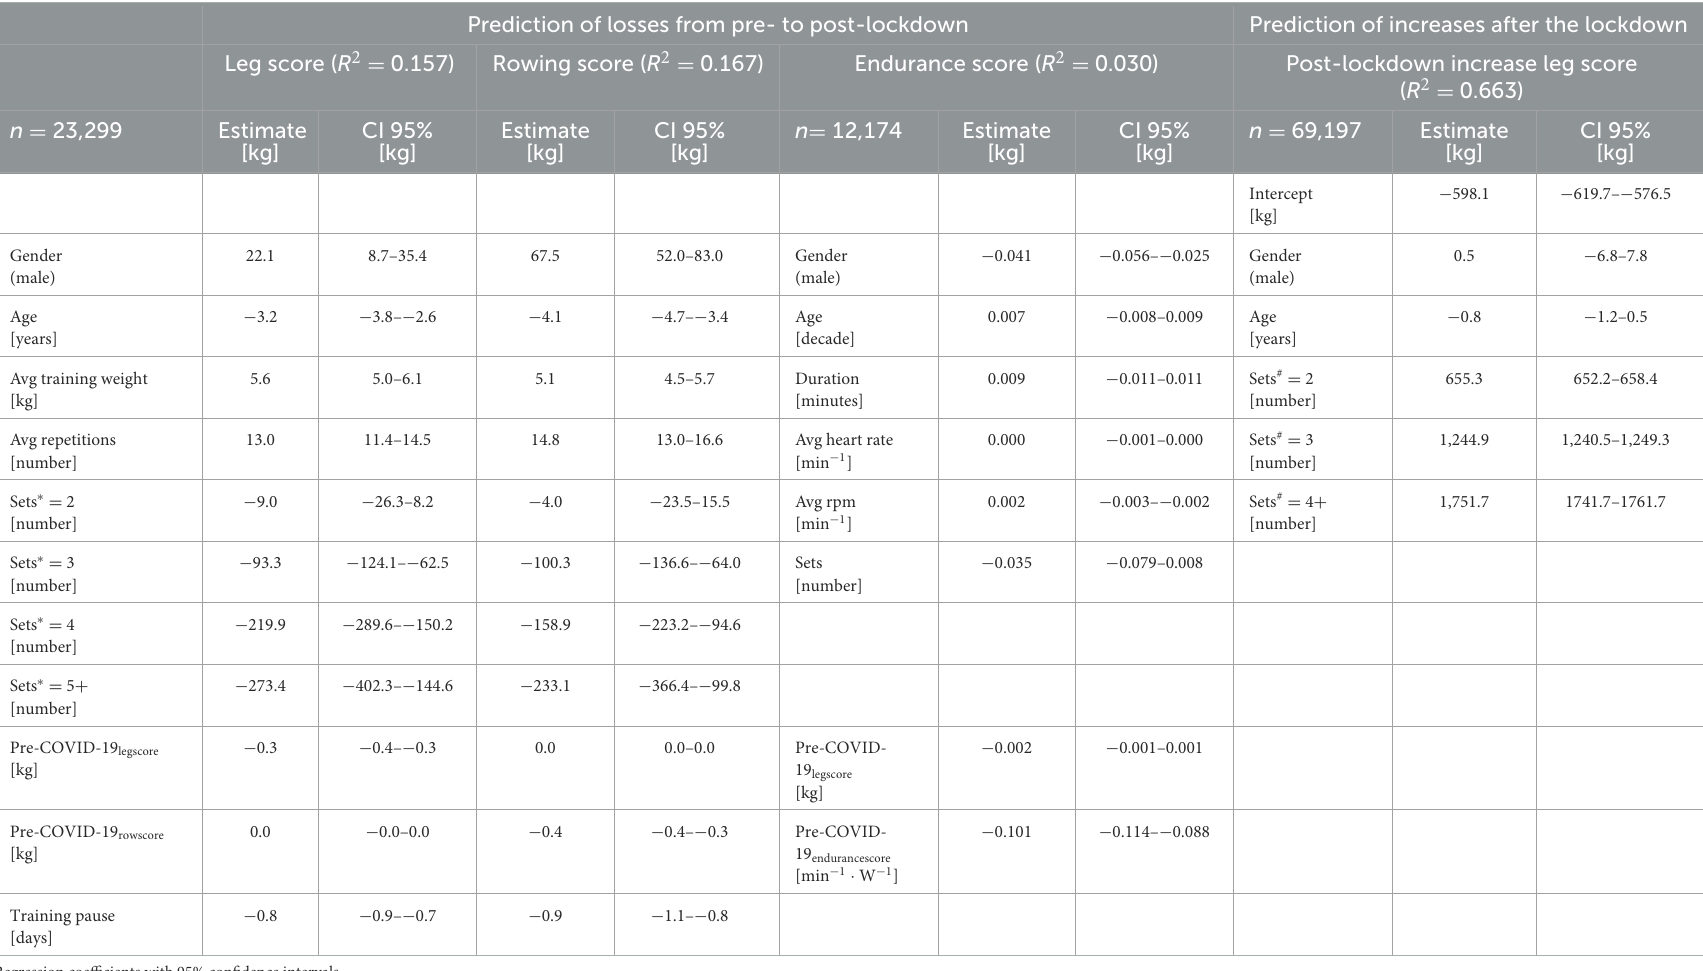
TABLE 3 Results of the linear regression models to predict losses in the leg, rowing, and endurance scores from pre- to post-lockdown and the generalized additive mixed regression model to predict the regain of the leg score after individual training resumption. Prediction of losses from pre- to post-lockdown Prediction of increases after the lockdown Leg score ( R 2 = 0.157) Rowing score ( R 2 = 0.167) Endurance score ( R 2 =